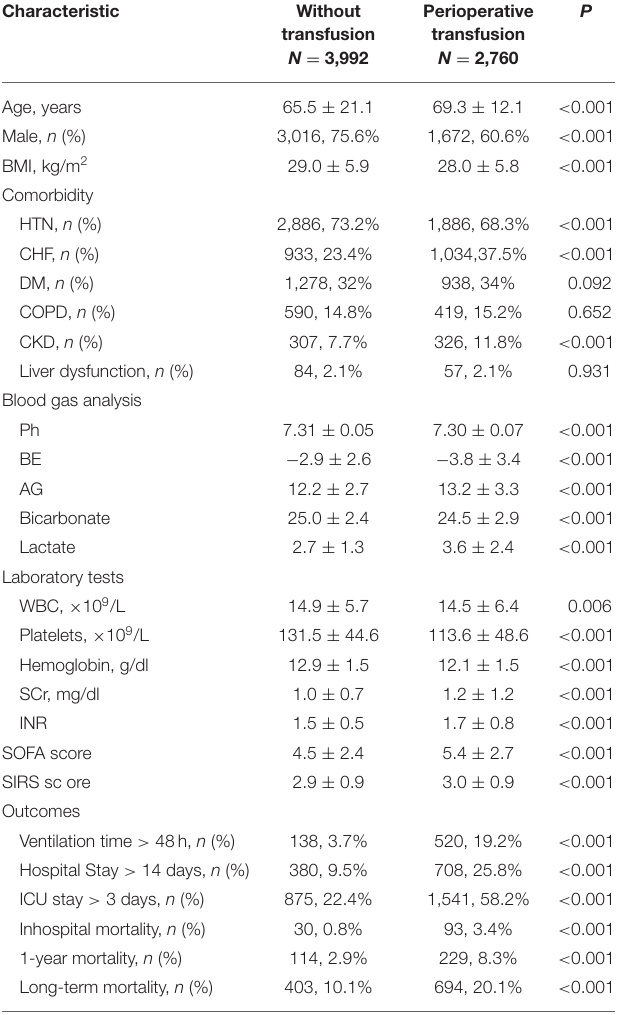
TABLE 1 | Baseline characteristics. TABLE 2 | Logistic regression model of the perioperative red blood cell transfusion and postoperative